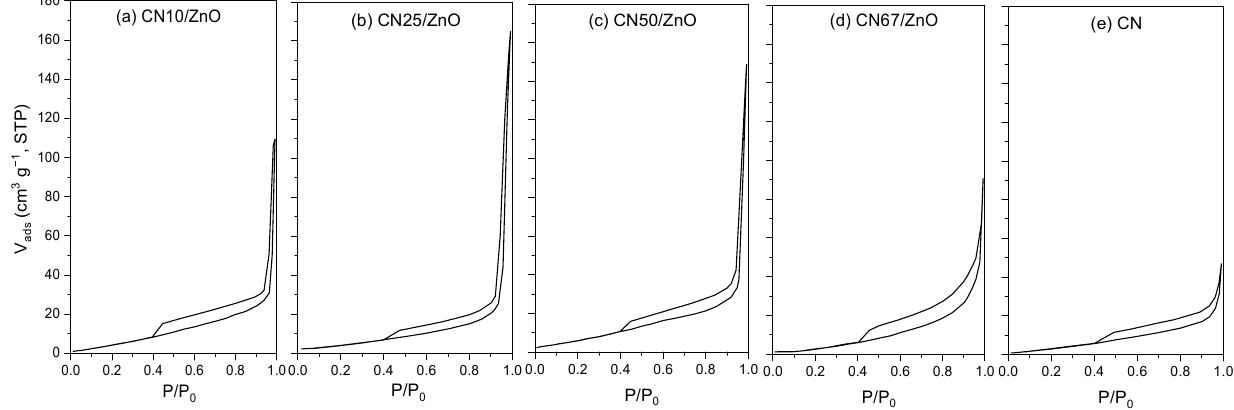
Figure 3. N 2 adsorption–desorption isotherms of ( a ) CN10/ZnO, ( b ) CN25/ZnO, ( c ) CN50/ZnO, ( d ) CN67/ZnO and ( e ) pure CN.